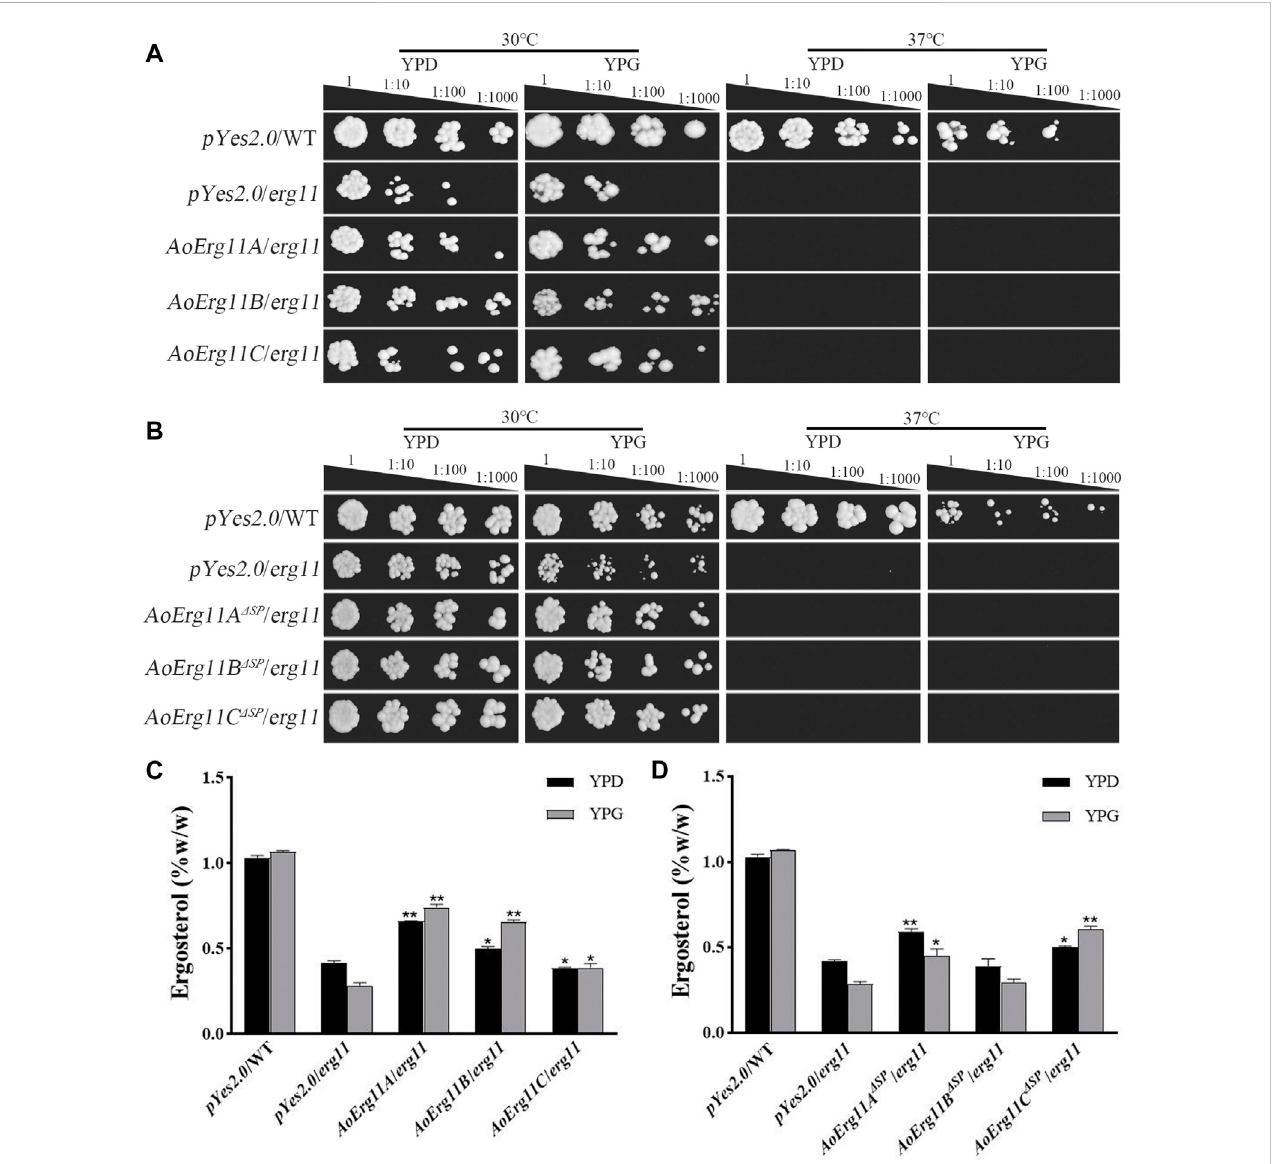
FIGURE 4 AoErg11s and AoErg11 Δ SP s could not recover the phenotypes of the erg11 mutant of S. cerevisiae (A,B) Growth of wild type, erg11 mutant (Y40597), AoErg11s / erg11 transformants and AoErg11 Δ SPs / erg11 transformants on YPD and YPG medium at 30 ° C and 37 ° C. (C,D) Measurement of ergosterol contents in alltransformants,thecontrolandtransformantswereculturedinliquidYPDandYPGfor2 daysat30 ° C,andtheyeastwerecollectedtodeterminethecontent ofergosterol.Statisticalanalyseswereperformedby t -testofGraphPad(*, p < 0.05;**, p < 0.01).Theergosterolcontentofeachexperimentalgroupwas compared with the pYes2.0 / erg11 mutant in the corresponding medium. Values represent the mean ± SD of three independent